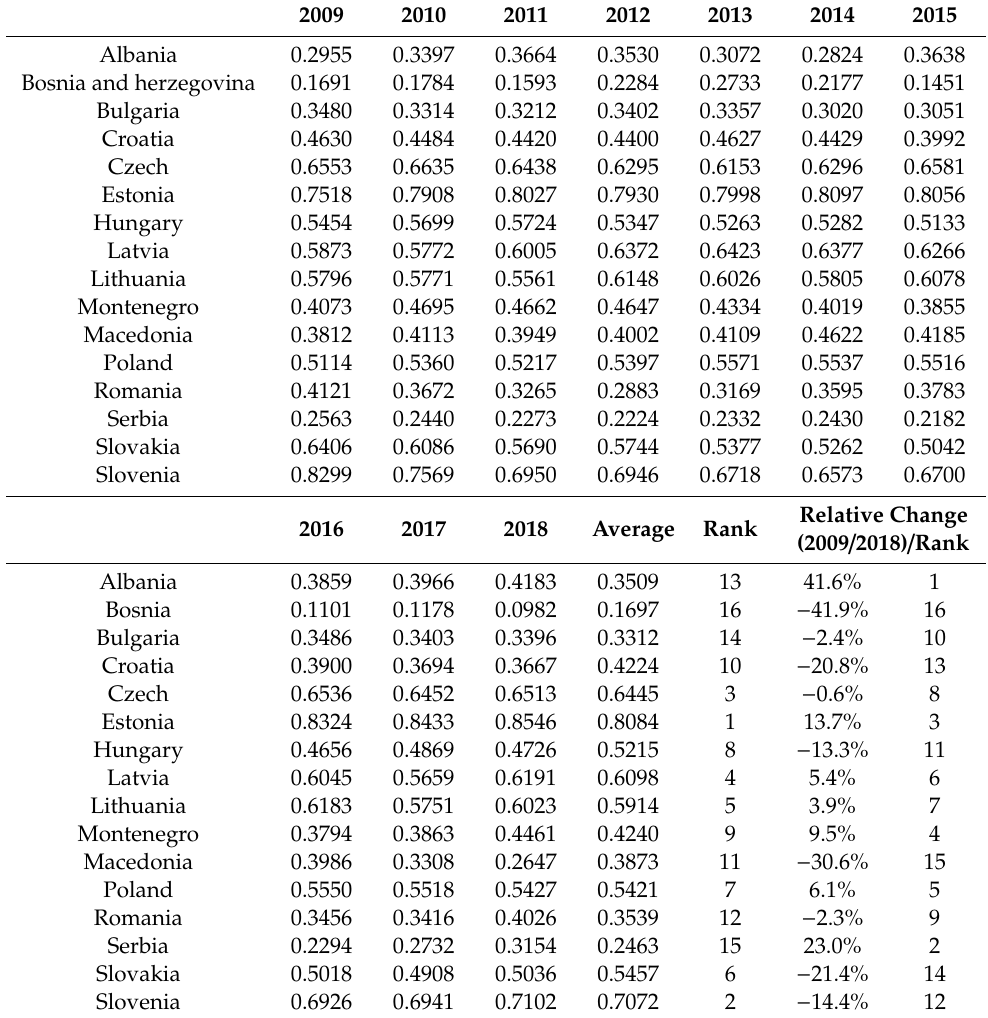
Table 5. Evaluation results of investment climate of CEE countries